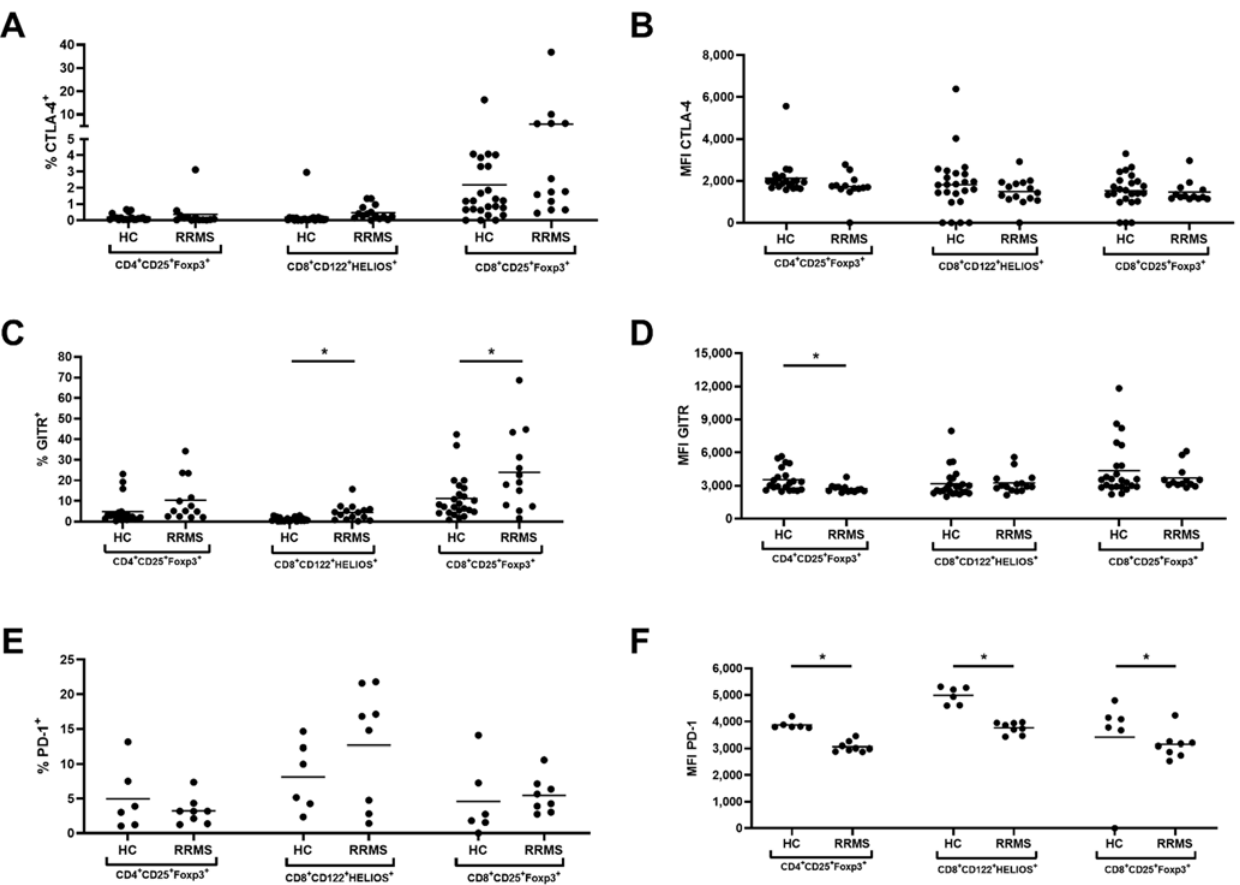
Figure 3. Expression of suppressive markers on CD4+ and CD8+ Treg populations. Comparison of the percentage and expression (MFI) of CTLA-4+ ( A , B ), GITR+ ( C , D ) and PD-1+ ( E , F ) cells within CD4+CD25+FoxP3+, CD8+CD25+FoxP3+ and CD8+CD122+Helios+ Treg populations in healthy controls (HC) and RRMS patients. * p ≤ 0.05.